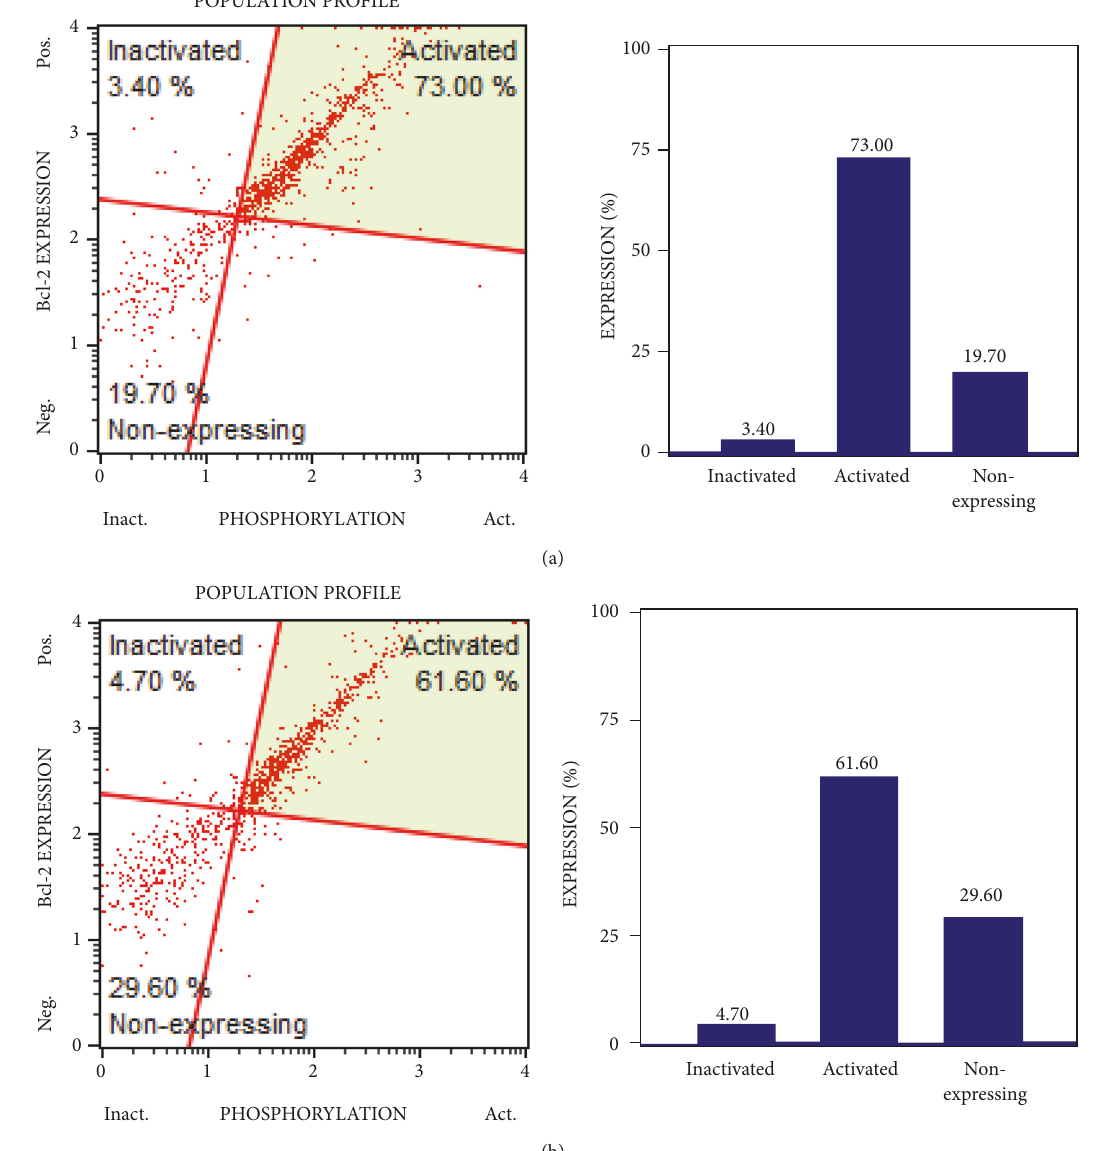
Figure 6: Bcl-2 activation and expression profile of 4,5-diCQA-treated DU-145 cells . MUSE Bcl-2 flow cytometric analysis for the control (a) and the 4,5-diCQA treated cells (b). 4,5-diCQA treatments were performed at IC 50 concentration (5 𝜇 M) for 72 hours, after which cells from control and treatment groups were collected, stained, and analyzed using a MUSE flow